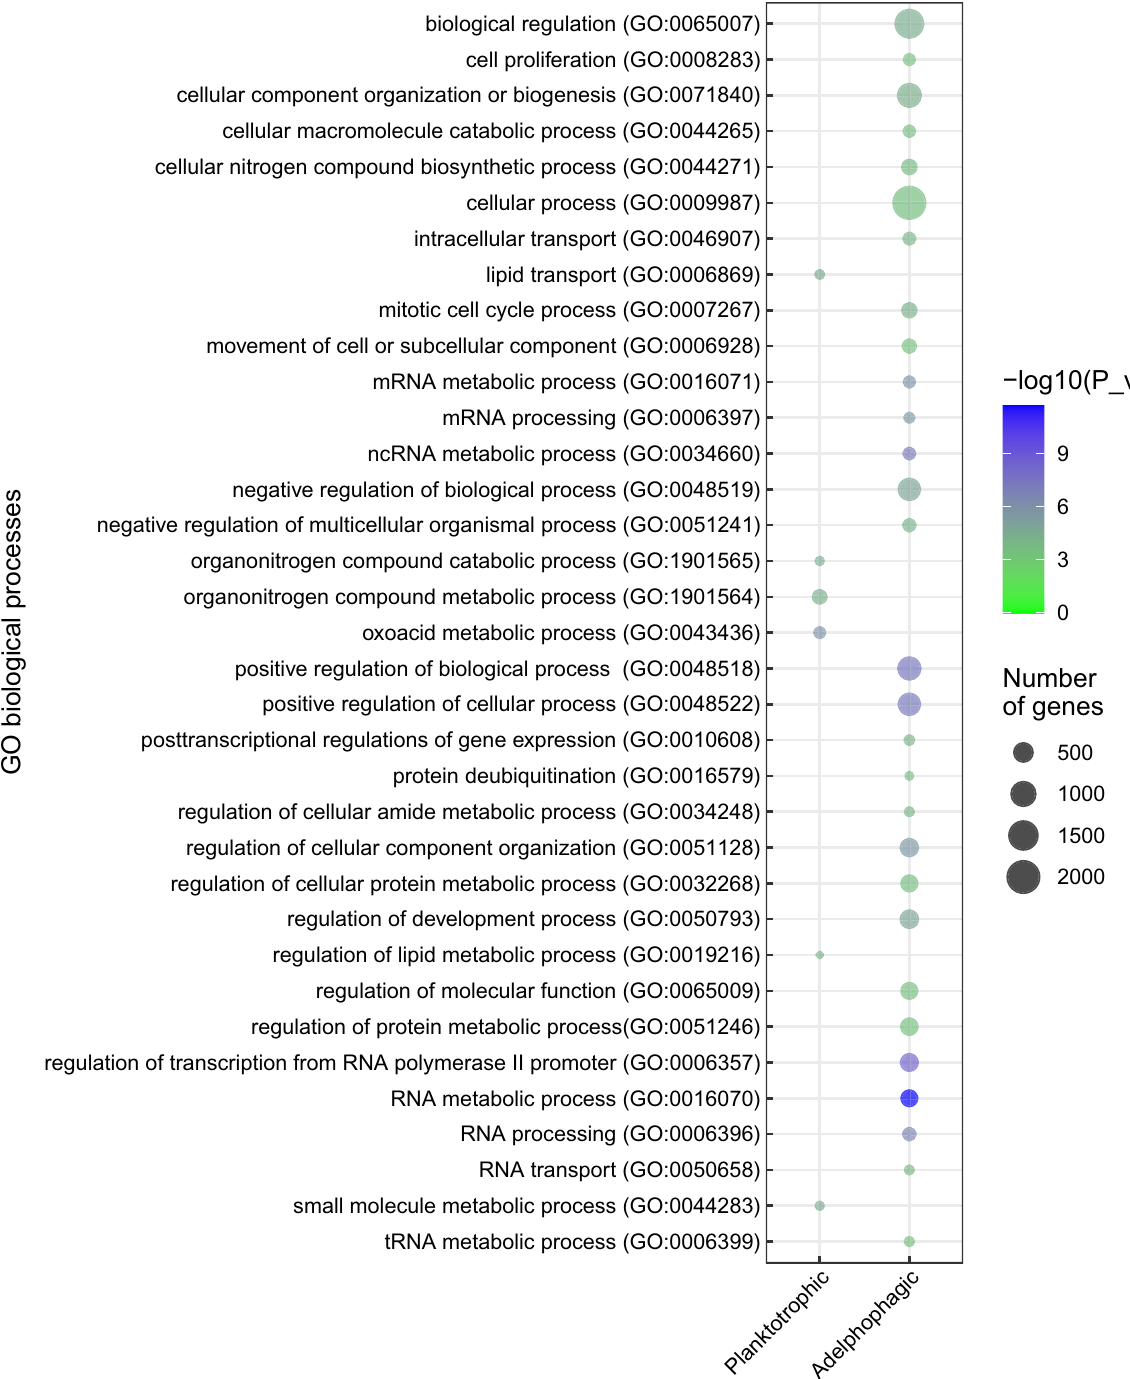
Figure 3. Plot of the enriched biological processes (FDR < 0.05) identified in adults, larval stages, planktotrophic (PLTI and PLTIII) and adelphophagic (EAL) larvae. The GO terms were collapsed in REVIGO. The size of the dot indicates the number of genes grouped in a GO term, and the color represents the significant enrichment -Log10(FDR). The vertical line represents the number of